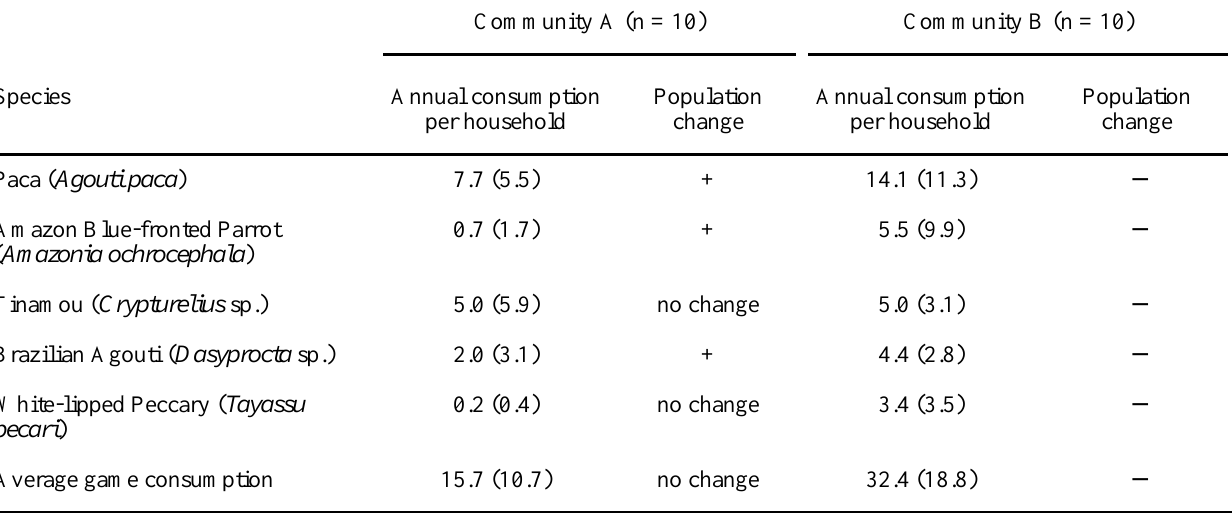
Table 4. Mean (SD) consumption of the top five hunted game animals (2003–2004), and changes in animal populations over the last ten years as reported by a random subsample of households.